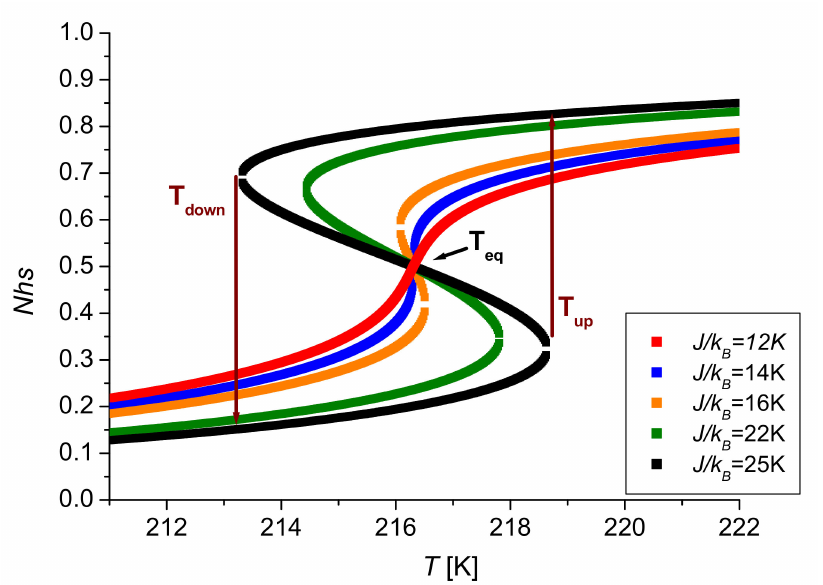
Figure 1. Thermal evolution of the HS fraction in a SCO system with a size of 6 × 6 for different values of the average interaction parameter J / k B : J / k B = 12 K (red square), J / k B = 14 K (blue square), J / k B = 16 K (orange square), J / k B = 22 K (green square) and J / k B = 25 K (black square). The computational parameters are: ∆ / k B = 1300 K, G / k B = 172.2 K, x = J HH / J LL = 1.0 and ln( g ) =